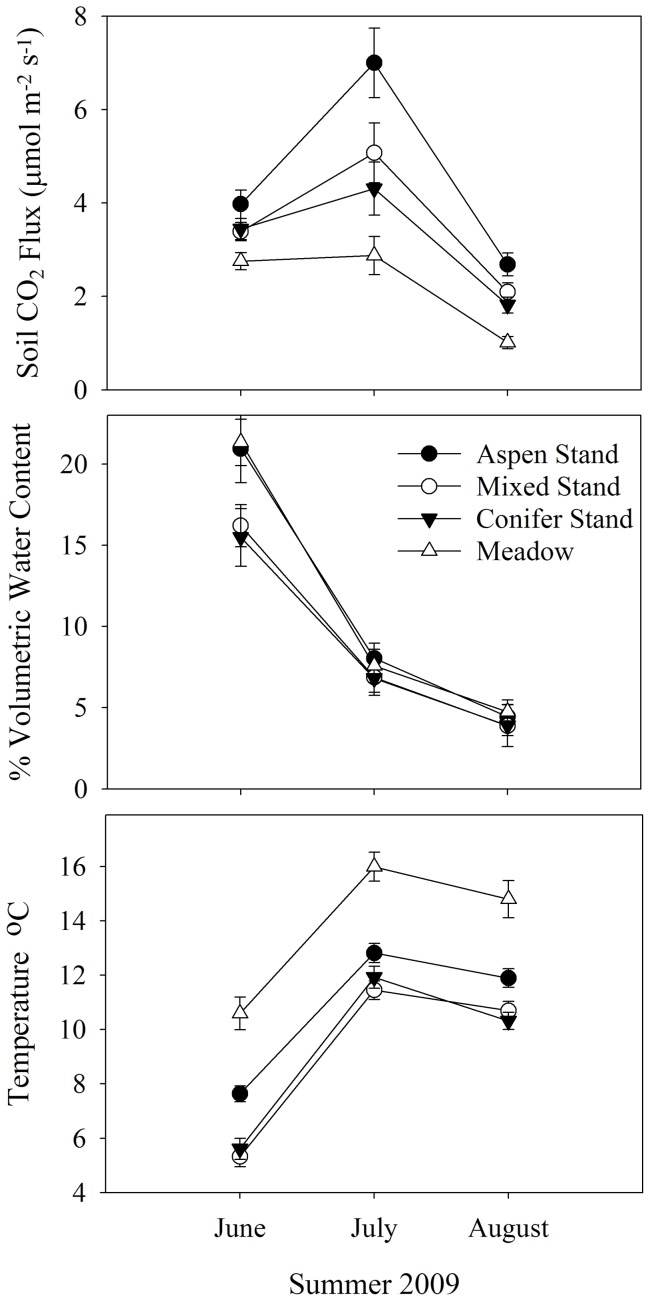
The influence of stand type on soil temperature, moisture and CO2 efflux over the summer of 2009.For soil temperature, the main effects in the repeated measures ANOVA model were significant but the interaction term was not: stand (F
3,80  = 38, P<0.0001), time (F F
2,79  = 94, P<0.0001), stand × time (F
6,158  = 1.7307, P<0.1171). For soil moisture, stand type was not significant (F
3,80  = 1.67, P = 0.17), but the main effect of time (F
2,79  = 249, P<.0001) and the stand by time interaction were significant (F
6,158  = 2.23, P = 0.04). For soil CO2 efflux both the main effects and the interaction term were statistically significant: stand type (F
3,80  = 11.7, P<0.0001), time (F
2,79  = 187, P<0.0001), stand × time (F
6,158  = 2.31, P = 0.03). Means presented as symbols with error bars ±1 SE.